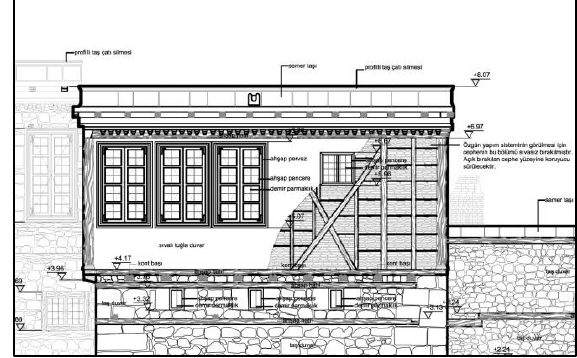
Figure 20. Northern View - Facade Detail (Restoration Project)